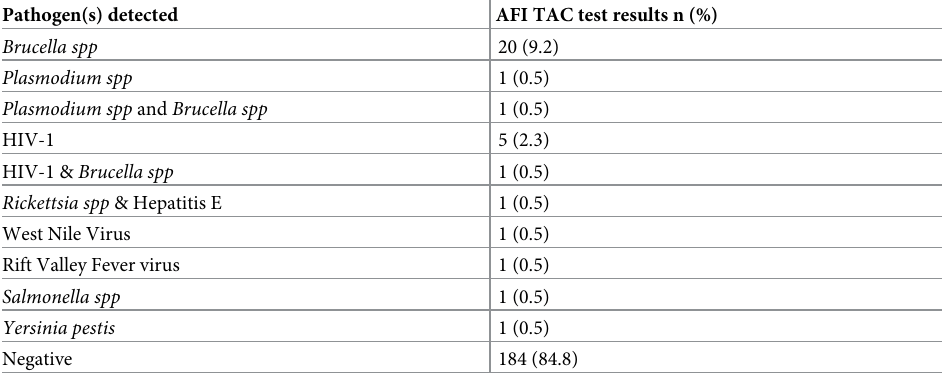
Table 3. Summary of etiologies of fever among patients by Acute Febrile Illness TacMann Array card (AFI TAC) testing in Kajiado, Kenya, 2015–2016 (n = 217) �